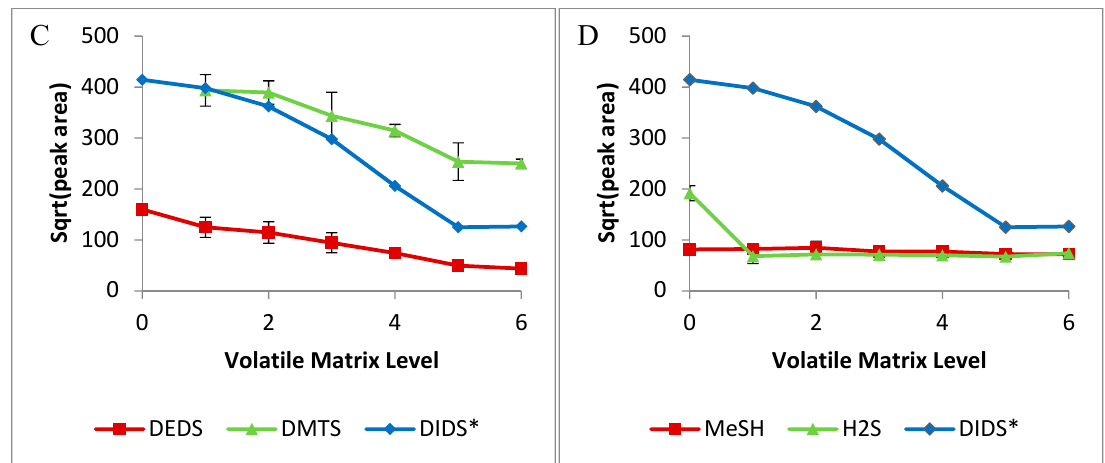
Figure 4. Effects of volatile acids, alcohols, and esters (across reported ranges in wine) on SPME adsorption of: ( A ) DMS and EMS (IS); ( B ) MeSOAc, EtSOAc, DES (IS), EIS (IS); ( C ) DEDS, DMTS, and DIDS (IS); ( D ) MeSH, H 2 S, and DIDS (IS).